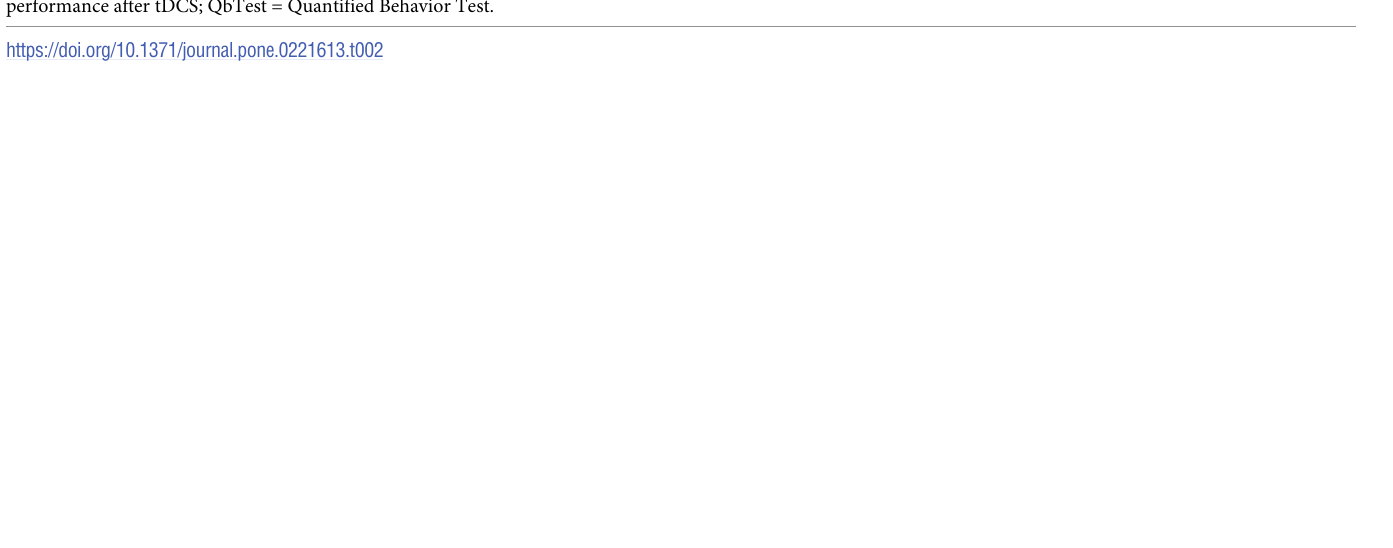
tDCS = transcranial direct current stimulation; F3 = left dlPFC; F4 = right dlPFC; Fp2 = right supraorbital area; online = task performance during tDCS; offline = task performance after tDCS; QbTest = Quantified Behavior